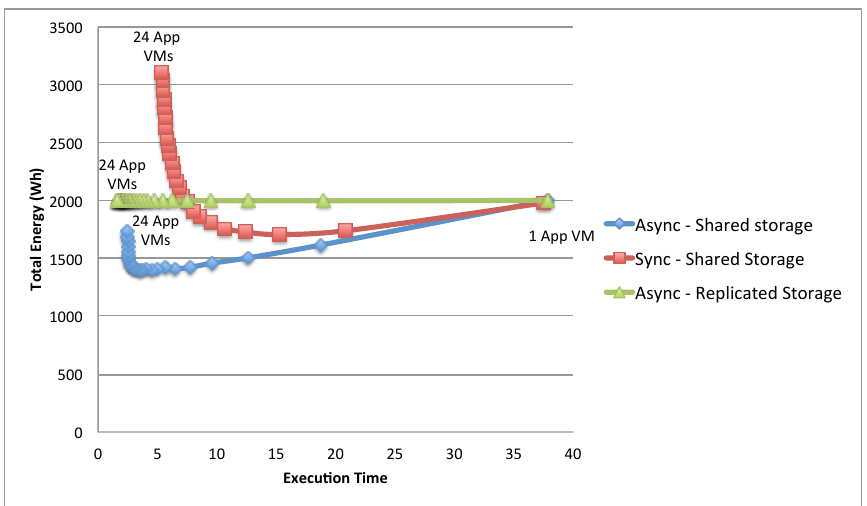
Figure 19. Total energy consumption by varying the number of